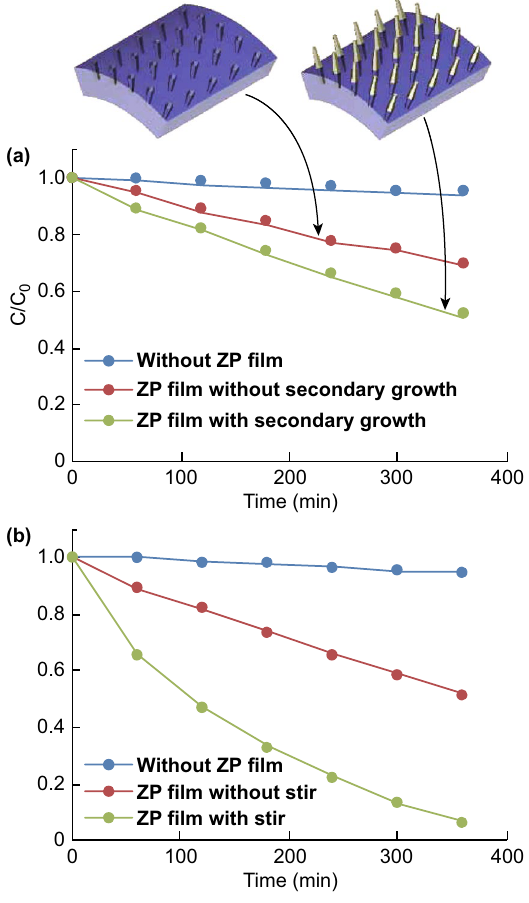
Fig. 7 Degradation profiles of the MB dye (at 667 nm) a before/after the secondary growth and b with/without magnetic